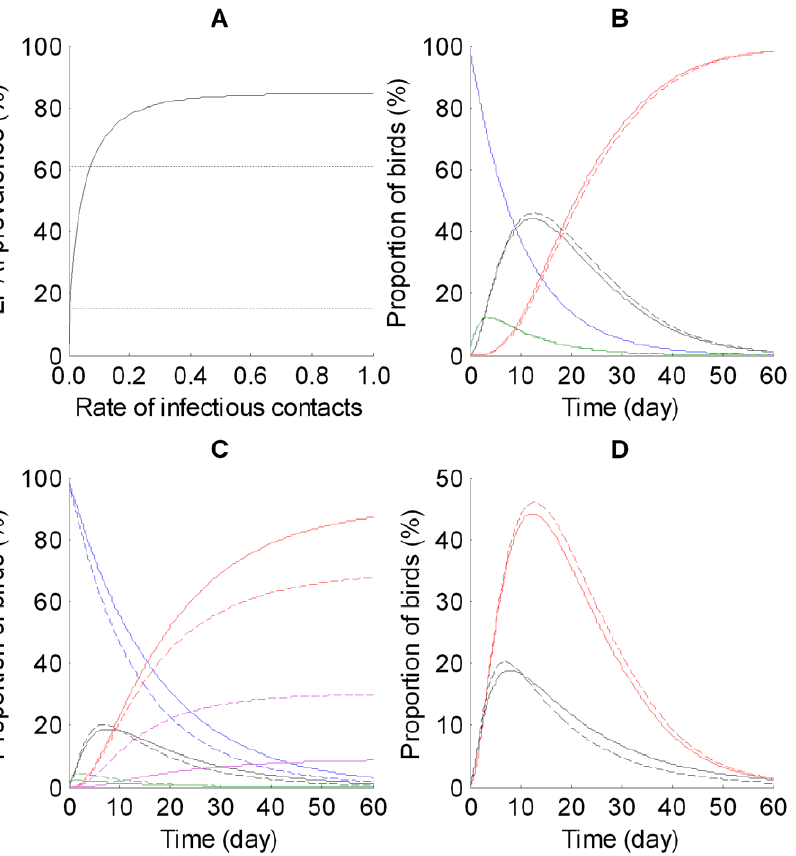
Figure 1. Predicted prevalence and disease dynamics in wild birds. A: LPAI peak prevalence for hatch-year waterfowl and estimated rate of infectious contact h ; h values between 0.01 and 0.08 corresponded with LPAI prevalence observed in young waterfowl at post-breeding areas (15– 61%, delimited by dotted lines). B and C: Predicted dynamics during LPAI and HPAI outbreaks, respectively, for Susceptible (blue), Exposed (green), Infectious (black), Recovered (red), and Dead (purple) birds in post-breeding (dashed lines) and wintering populations (solid lines). Graphs based on mean epidemiological parameters (Table 1) and an infectious contact rate ( h ) of 0.04. D. Comparison of prevalence dynamics during LPAI (red) and HPAI (black) epidemics in post-breeding (dashed lines) and wintering populations (solid lines).